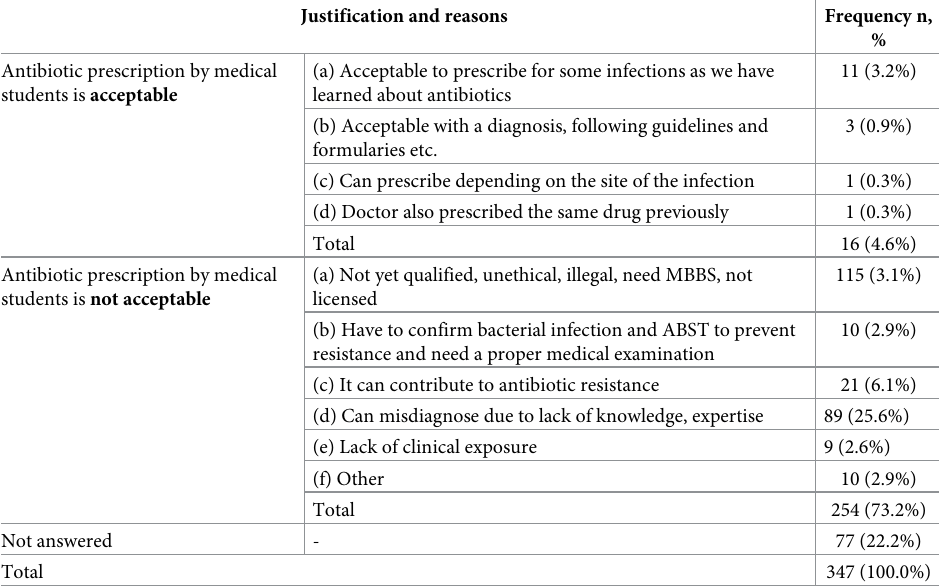
Table 5. Themes for reasons in justifying or not justifying antibiotic prescription by medical